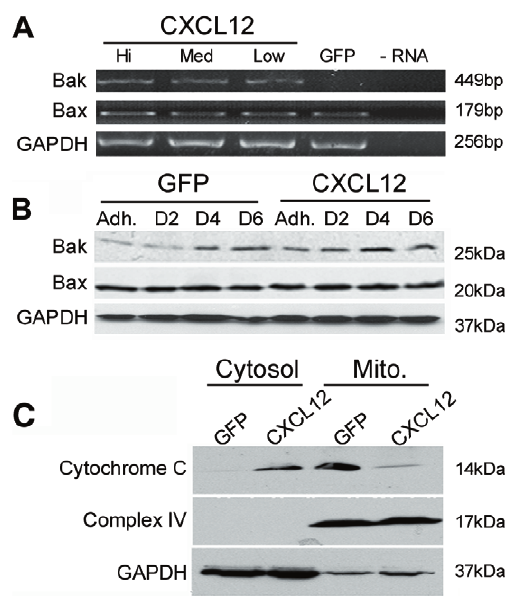
Figure 5. Bak expression is upregulated in non-adherent colorectal carcinoma cells expressing CXCL12. (A) HT29 stable cell lines expressing varying levels of CXCL12 were plated for 4-days on poly-HEMA [10 mg/ml]. RT-PCR analysis shows an increase in Bak but not Bax transcript levels in CXCL12-expressing cells in relation to control GFP cells. (B) Immunoblot analysis confirms increased Bak protein levels in CXCL12-expressing cells cultured in suspension for either 2, 4 or 6 days (D2, D4, D6) compared to control. (C) Mitochondrial fractionation and immunoblot analysis of GFP and CXCL12 cells after four days of anchorage-independent growth indicated a release of cytochrome c into the cytosol in CXCL12-expressing cells. Complex IV, a resident mitochondrial protein, confirmed efficient fractionation and GAPDH served as a loading control. Data are representative of 4 independent